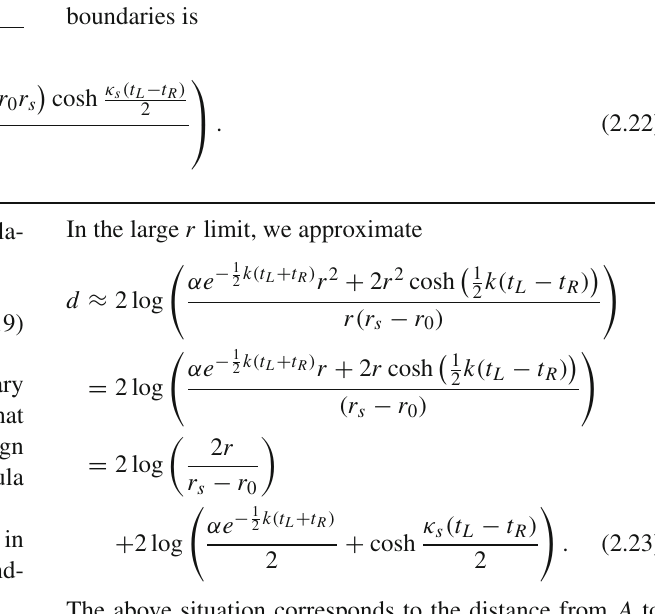
Fig. 3 The Kruskal–Szekeres and the Penrose schematic diagrams for the geometry with a shock wave from the left boundary. The green line represents the acoustic horizon r = r s . The blue line in the Kruskal figure represents the location of r = 0 and r = ∞ . We can see the green lines with UV = 0 and acoustic horizons is staggered by a displacement α . The regions A and B are in the AdS boundary, which is black line sketched in Penrose diagram and the length of the black line corresponds to the distance d (cid:4) in formula